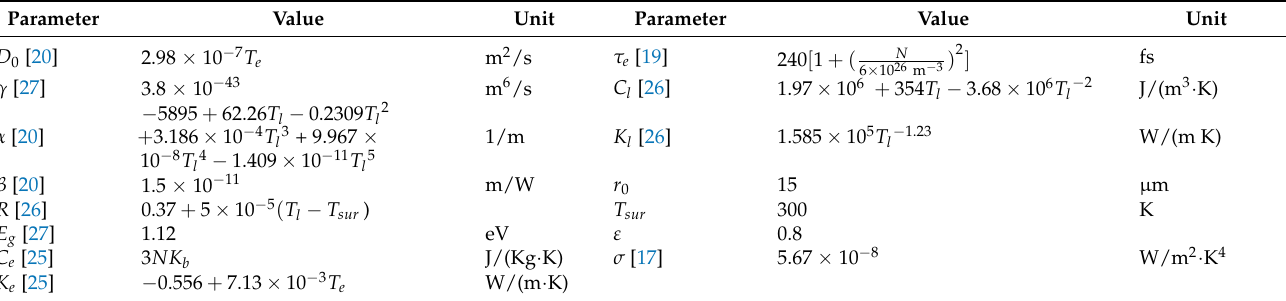
Table 1. Model parameters and values of